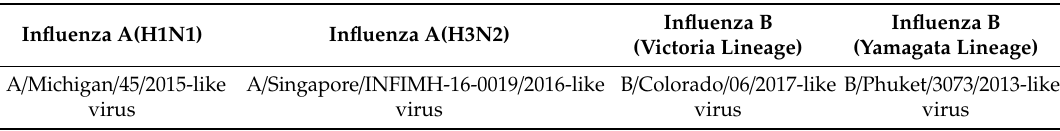
Table 1. Components of 2018–2019 Quadrivalent